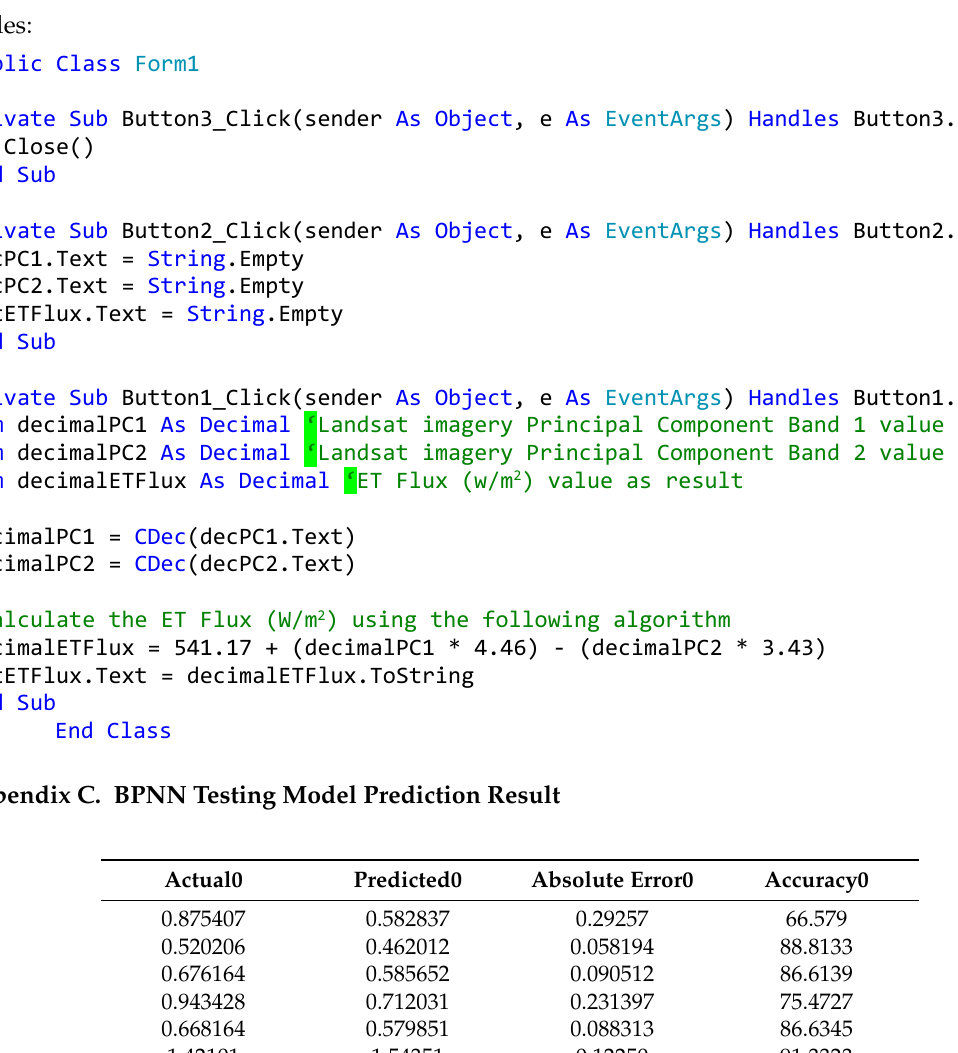
Figure A2. Executable file worked out